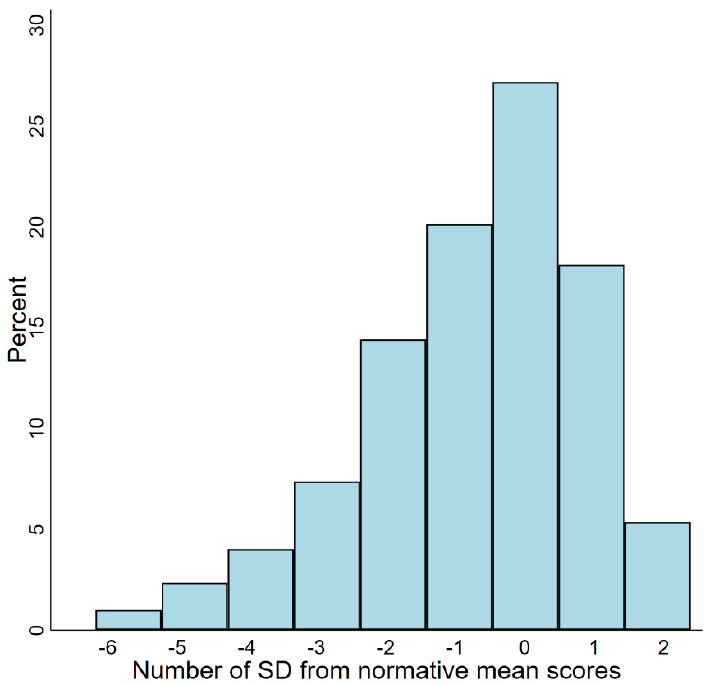
Figure 2. Distribution of MoCA z-scores (SD) based on Norwegian normative data. Table 3. Characteristics of MoCA test completers and non-completers at 16 weeks after